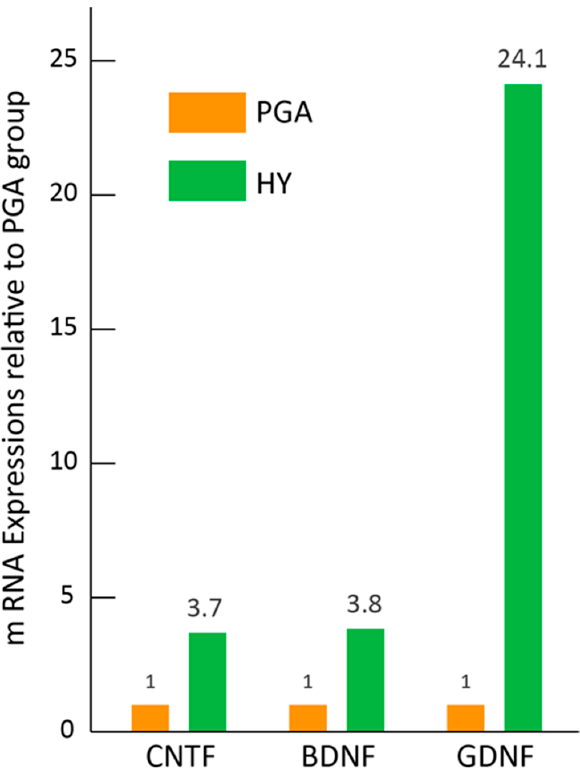
Figure 7. Expression of peripheral nerve growth promotional factor mRNAs in the HY group. Expressions of CNTF, BDNF, and GDNF in the HY group were examined by real-time qPCR relative